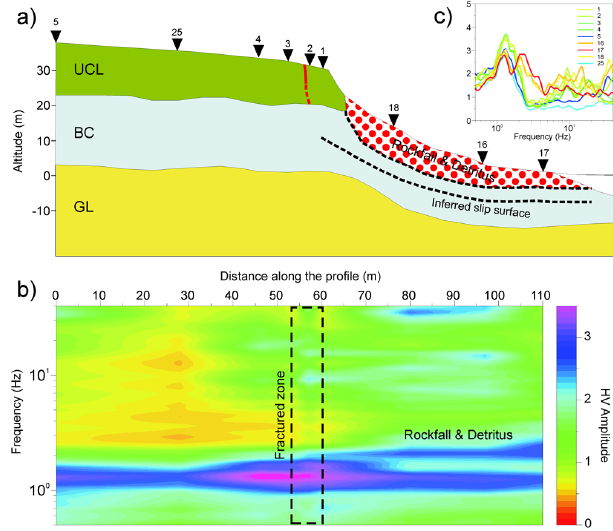
Fig. 8. (a) Cross section along the A–B profile in Fig. 2c; (b) 2-D diagram obtained combining all the ambient noise measurements along the profile as a function of distance (x-axis) and frequency (y-axis); and (c) HVSR results at the recording sites located across the